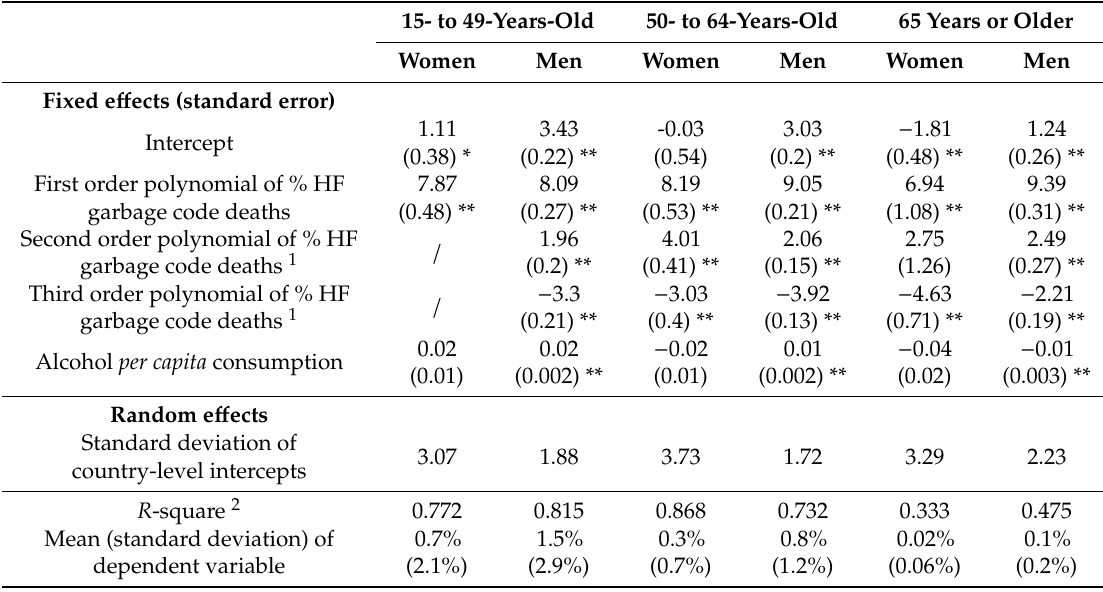
Table A6. Results of regression models on % ACM deaths among all CVD deaths by age and